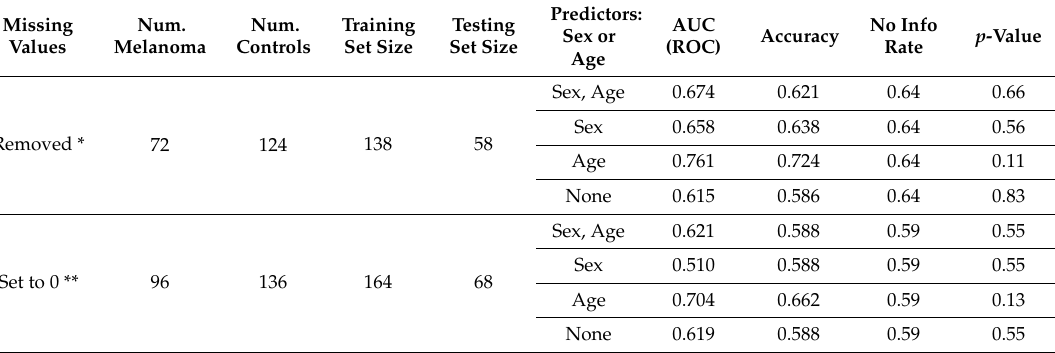
Table 7. Results of the SVM method applied to the serum expression dataset. Missing values are either removed or assigned as zero. In the first case, some molecules are removed from the predictor values (remaining molecules are listed in the “Molecules” column). Sex and / or age are or are not regarded as predictors. The p -value is the probability that the “Accuracy” value is not significantly above the “No Info Rate”